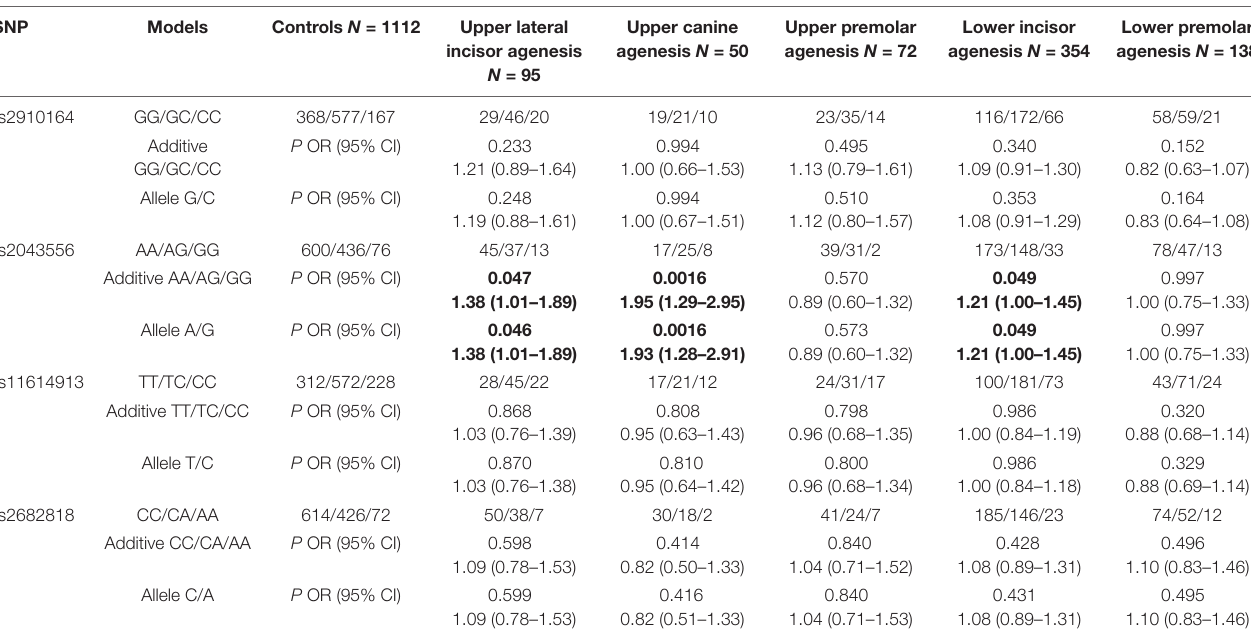
TABLE 2 | Association of the four miRNA gene SNPs with the risk of different types of teeth